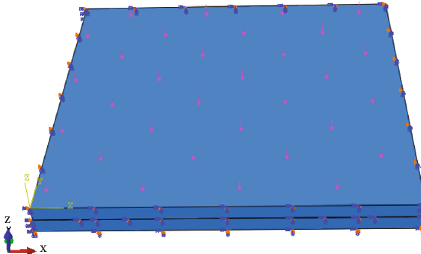
Figure 11: Finite element model of fracturing crack-proppant column interaction in high-conductivity channel.